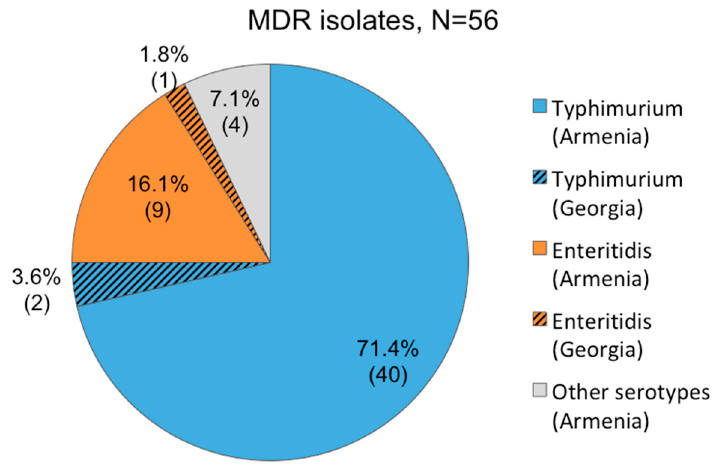
Figure 3. Serotype distribution in multidrug resistant (MDR) Salmonella enterica isolates isolated from patients with salmonellosis in Armenia (53 isolates) and Georgia (three isolates).